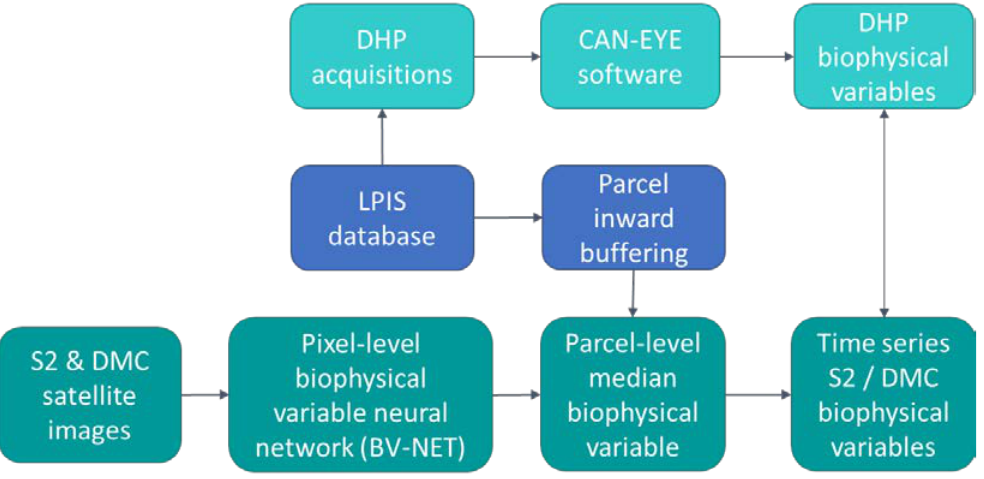
Figure 1. Flow diagram of data processing.